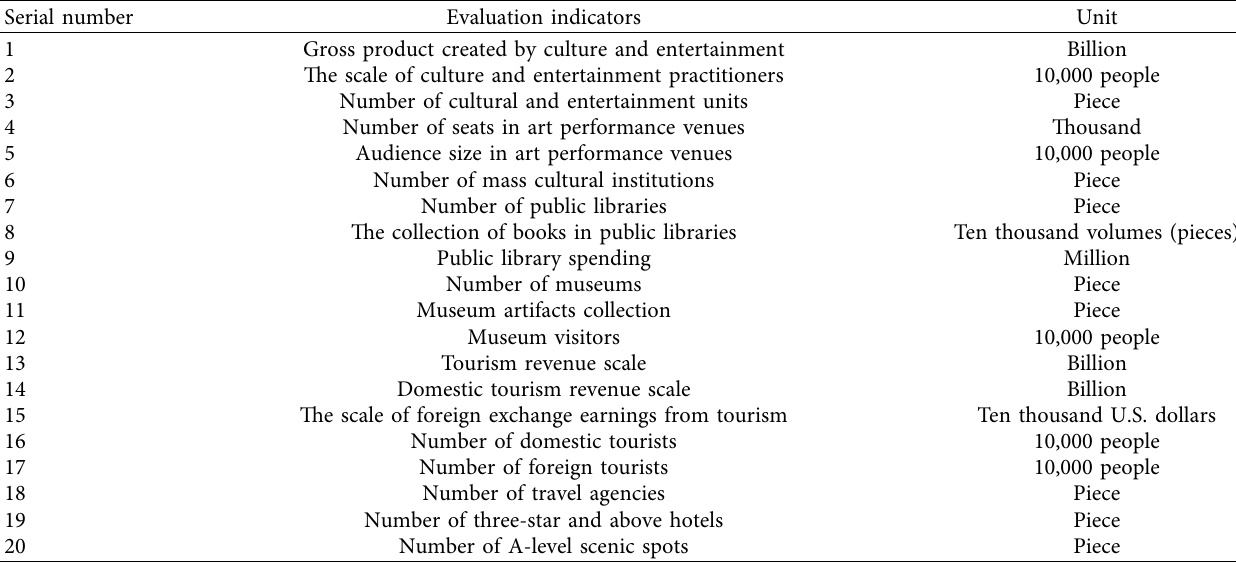
Table 2: Indicator system for measuring the development level of cultural industry and tourism industry.